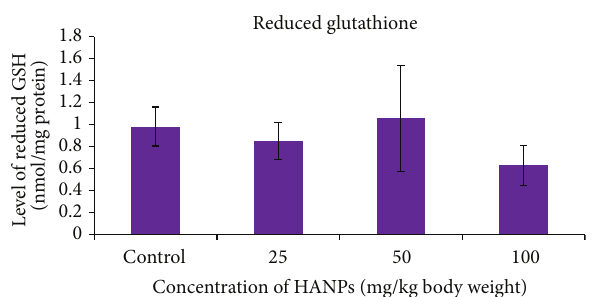
Figure4:LevelofGSHintheliverofratexposedtoHANPs(mean ± SD, 𝑛 = 5 ).